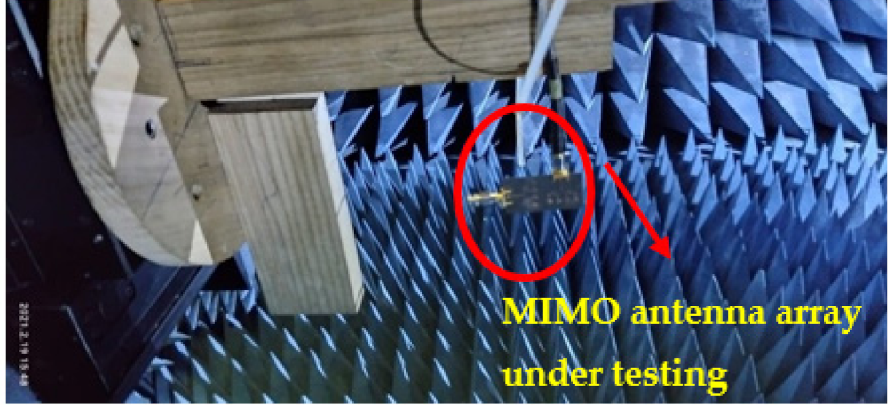
Figure 6. Proposed MIMO antenna array under